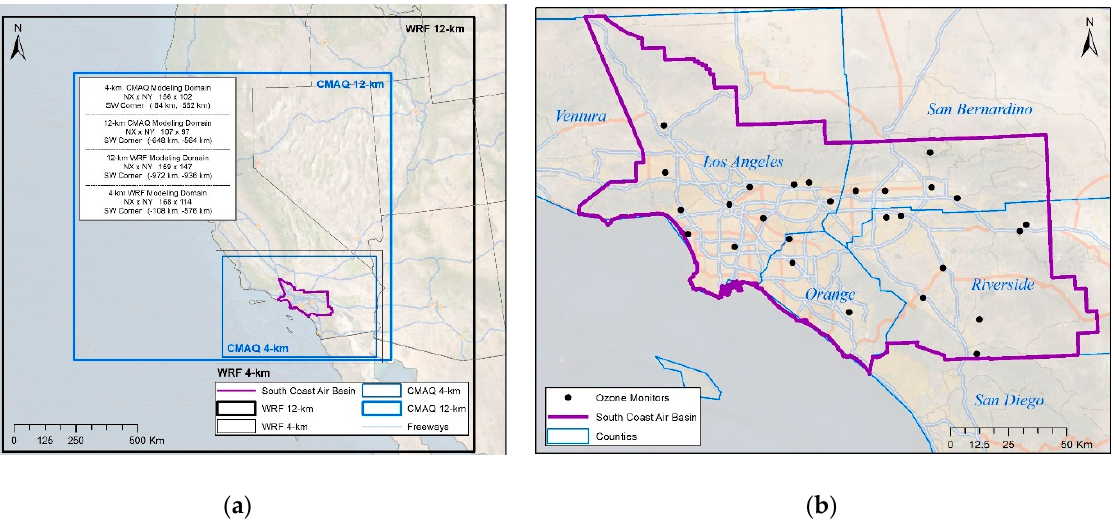
Figure 1. Study area: ( a ) Geographic extents and modeling domain parameters; ( b ) South Coast Air Basin study region with monitor locations and SoCAB counties.